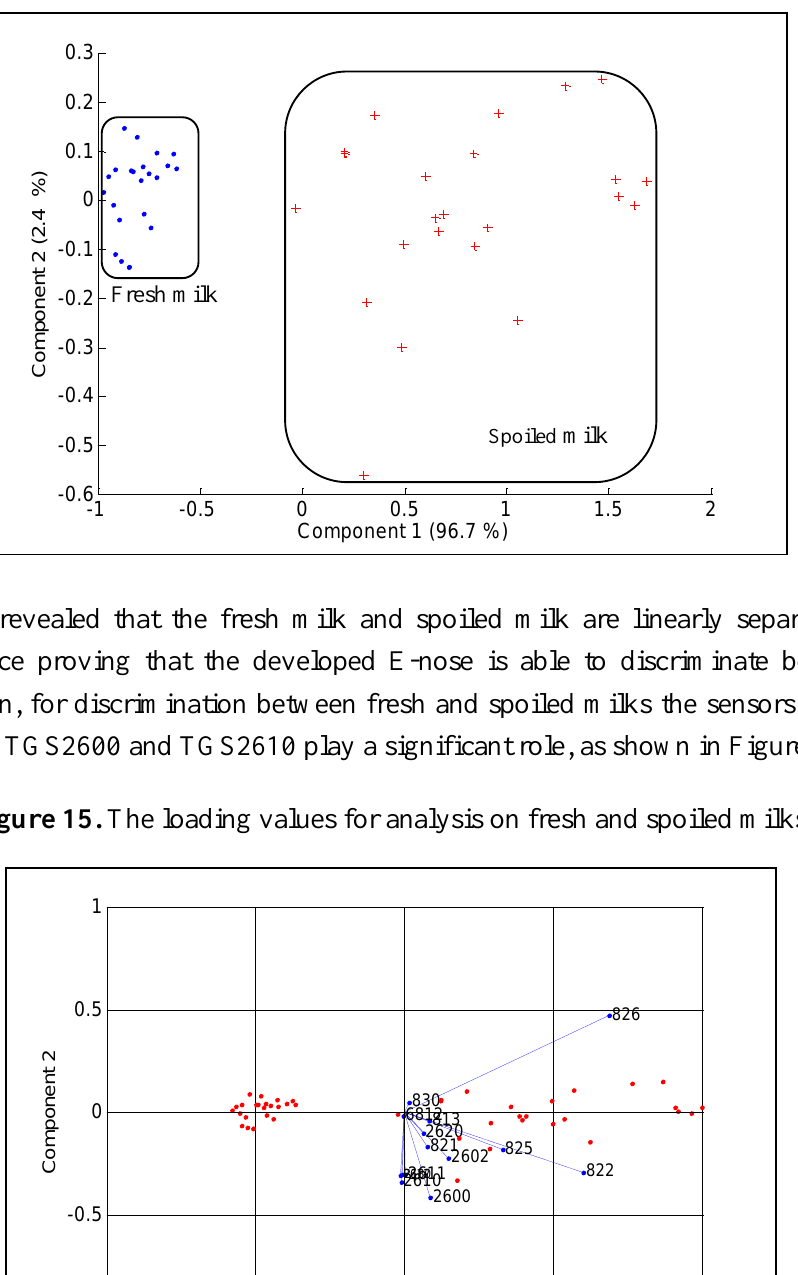
Figure 14. The PCA plot of fresh and spoiled milk.